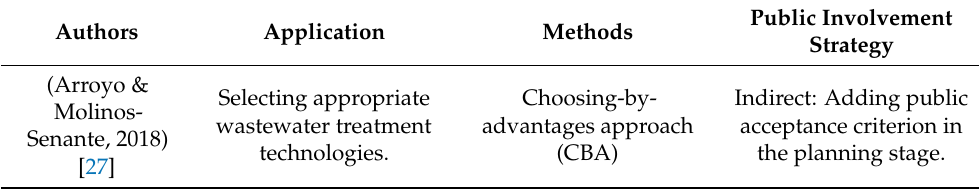
Table 1. Current research on public involvement in